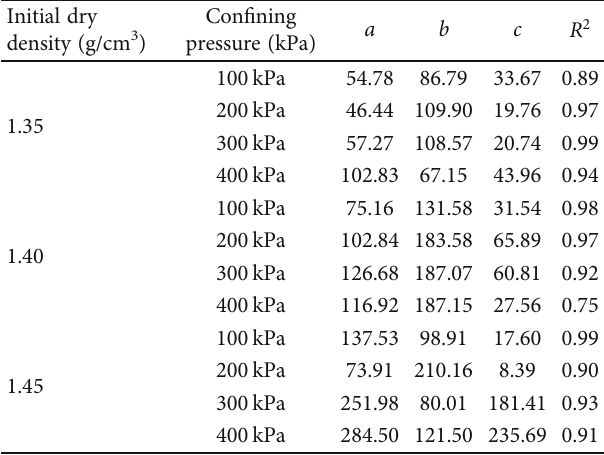
Table 4: Fitting table of the relationship between chromium pollution concentration and deviator